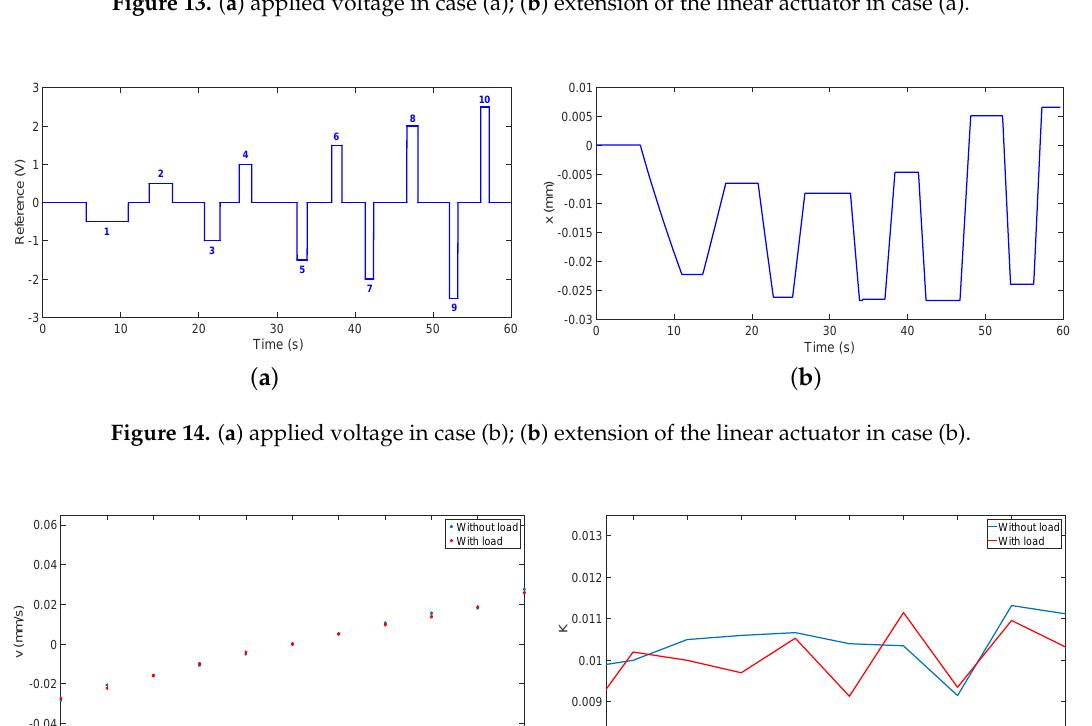
Figure 13. ( a ) applied voltage in case (a); ( b ) extension of the linear actuator in case (a).